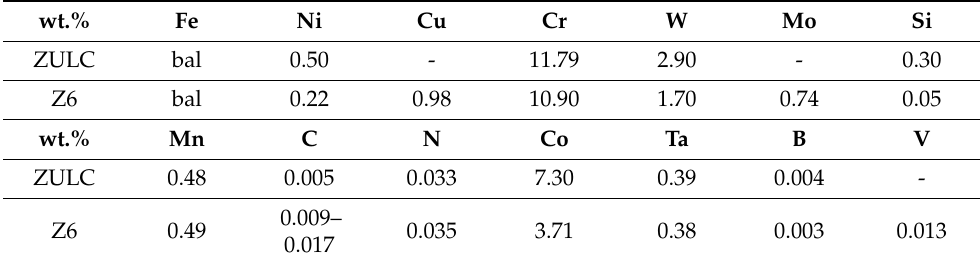
Table 1. Chemical composition of materials in